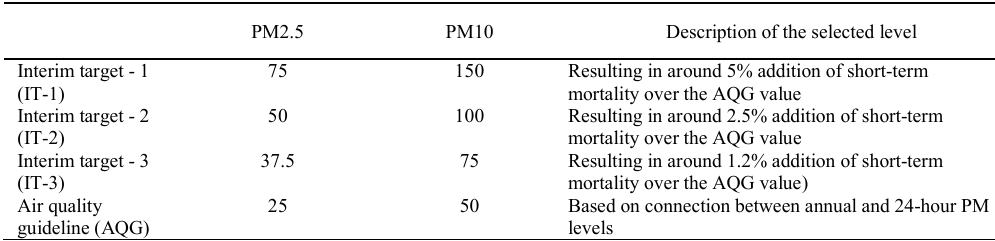
TABLE II WHO AIR QUALITY GUIDELINES : 24- HOUR MEAN PM2.5 PM10 Description of the selected